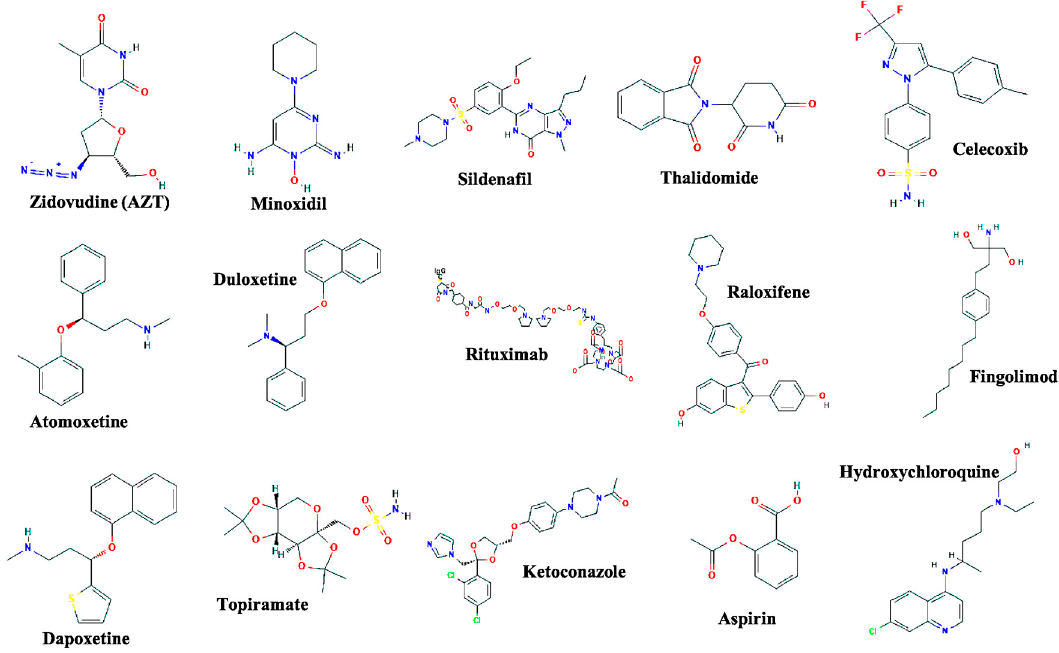
Figure 1. Chemical structures of the drugs that are efficacious examples of drug repurposing approach and are approved by the FDA for their multiple applications. The chemical structures are adapted from (pubchem.ncbi.nlm.nih.gov/).